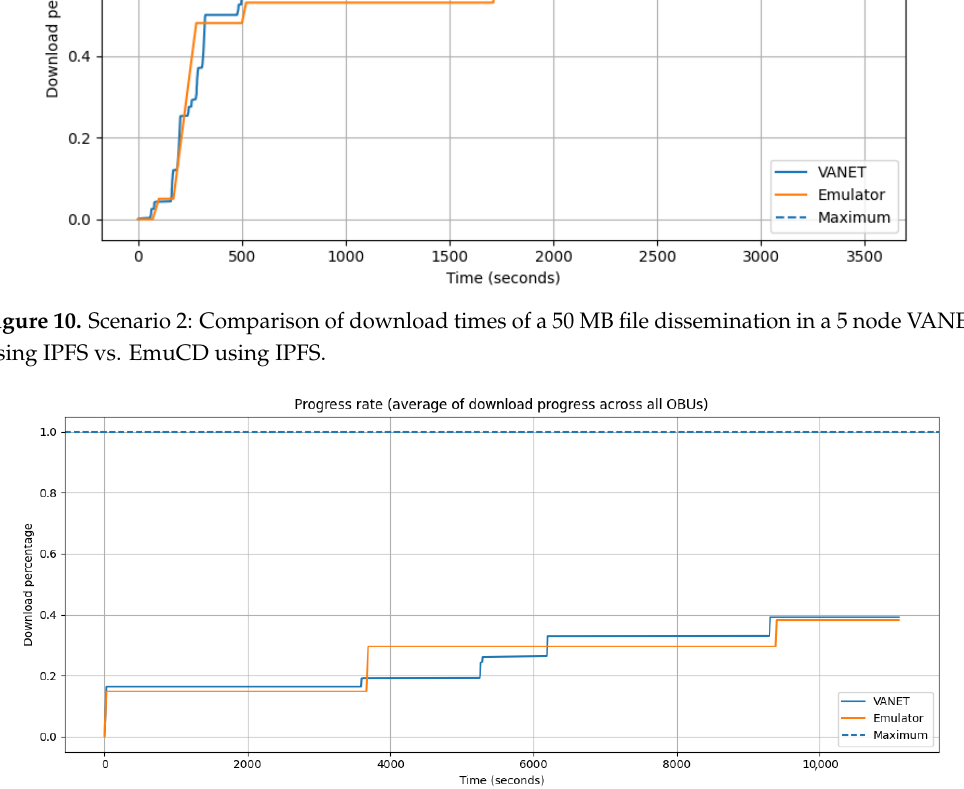
Figure 11. Scenario 3: Comparison of download times of a 50 MB file dissemination in a 5 node VANET using IPFS vs. EmuCD using